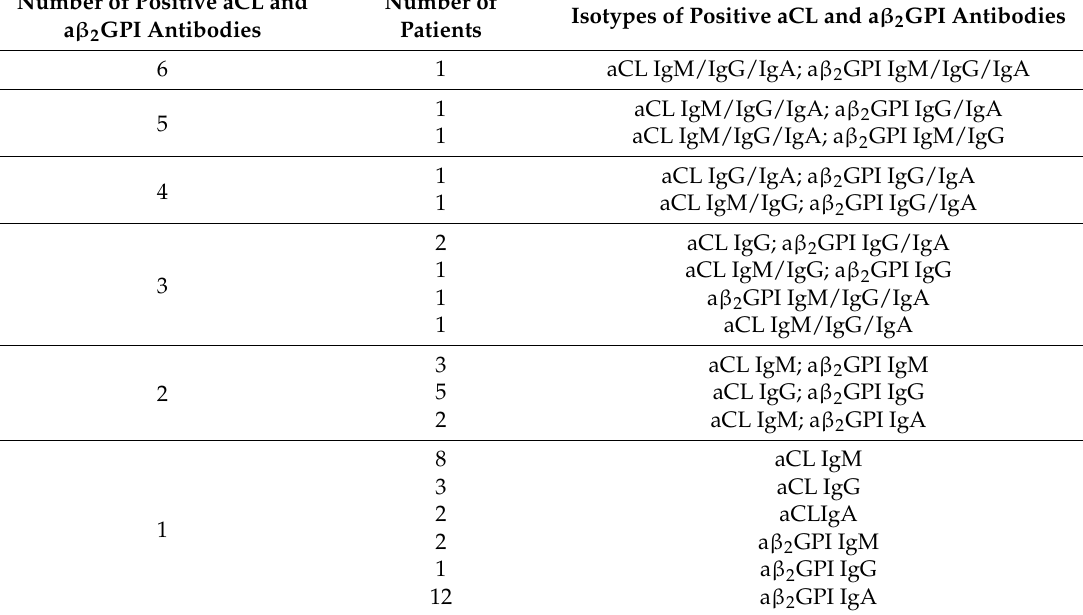
Table 3. Distribution of anti-Cardiolipin (aCL) and anti- β 2 GPI (a β 2 GPI) antibodies in SLE patients. Number of Positive aCL and